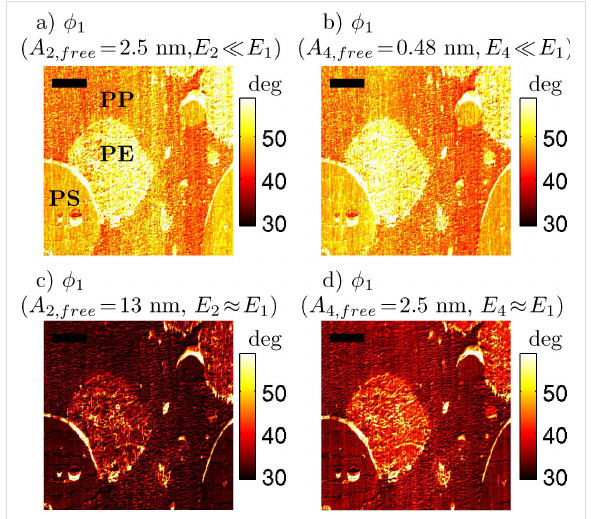
Figure 3: The same experiment as Figure 2, plotting first eigenmode phase lag . In the top row (a, b) the first eigenmode has a larger energy than the higher mode (2nd or 4th, respectively). In the bottom row (c, d), the first eigenmode energy is comparable to the higher eigenmode energy. The first eigenmode phase drops considerably between the top and bottom rows, indicating that in the high energy state there is a nonlinear coupling between the eigenmodes that is affecting the first eigenmode. This is clearly due to the energy ratios, and not the choice of higher eigenmode (i.e., little difference between left and right columns). The scale bar is 2 μ m.